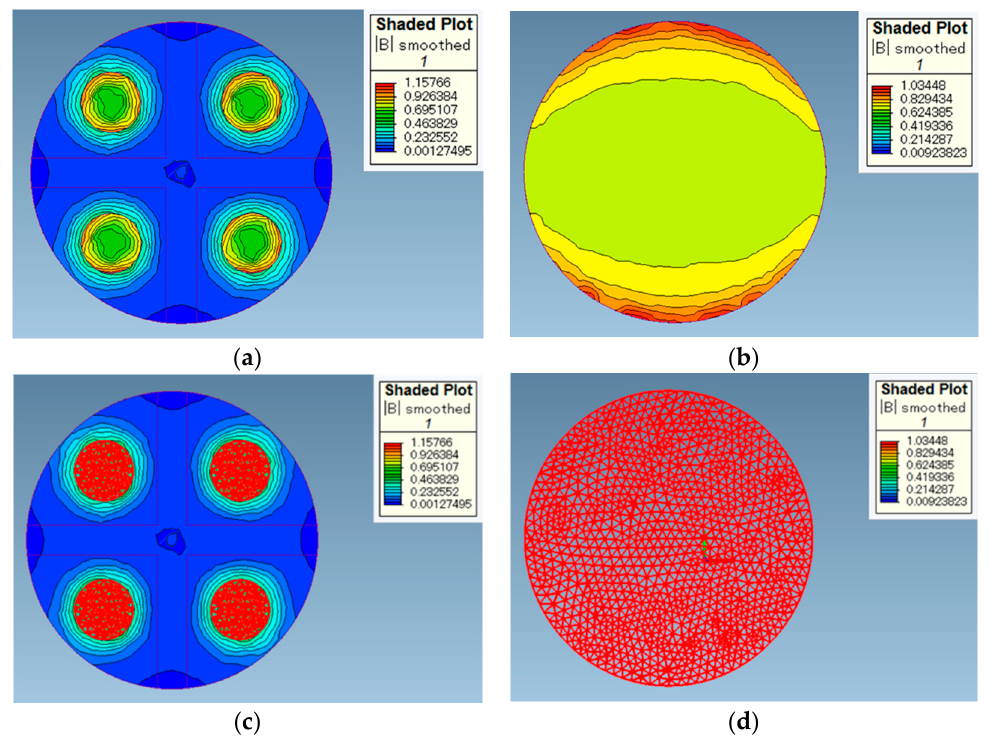
Figure 13. Using Magnet Version 7 software to analyze the magnetic flux density of the electrolytic magnetic compound machining tool and traditional magnetic machining tool: ( a ) magnetic flux density of electrolytic magnetic compound machining tool; ( b ) magnetic flux density of traditional magnetic machining tool; ( c ) magnetic flux density with mesh grid for electrolytic magnetic compound machining tool; ( d ) magnetic flux density with mesh grid for traditional magnetic machining tool.